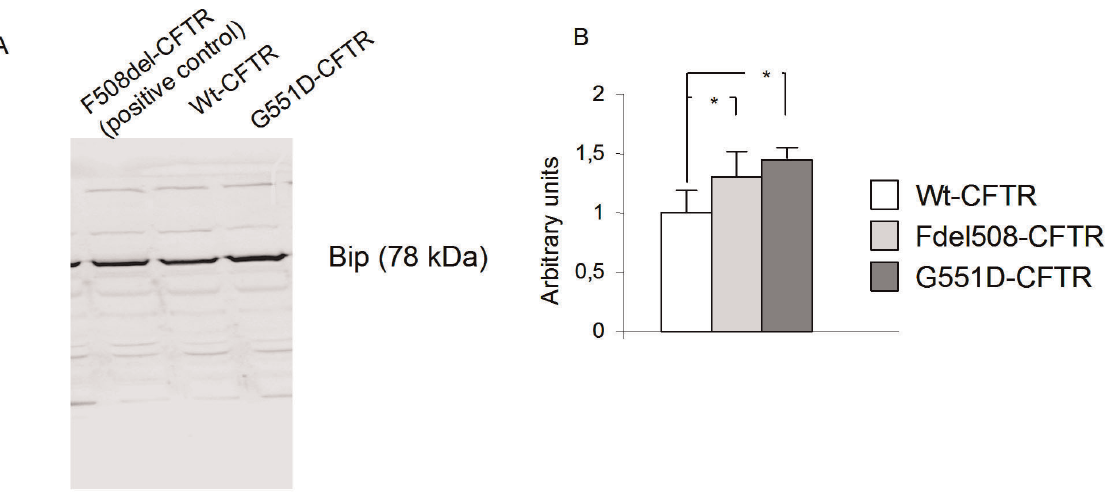
Figure 4. UPR is likely triggered in G551D-CFTR expressing cells. A, Example of detection of Grp78 in Wt-CFTR, Fdel508-CFTR and G551D- CFTR expressing cells, assessed by western blotting using whole cell lysates. A Fdel508-CFTR expressing cell lysate was used as a positive control. B, Histogram represents the quantitation indicating that the amount of Grp78 is increased in Fdel508-CFTR and G551D-CFTR expressing cells whereas no difference is observed between Fdel508-CFTR and G551D-CFTR expressing cells